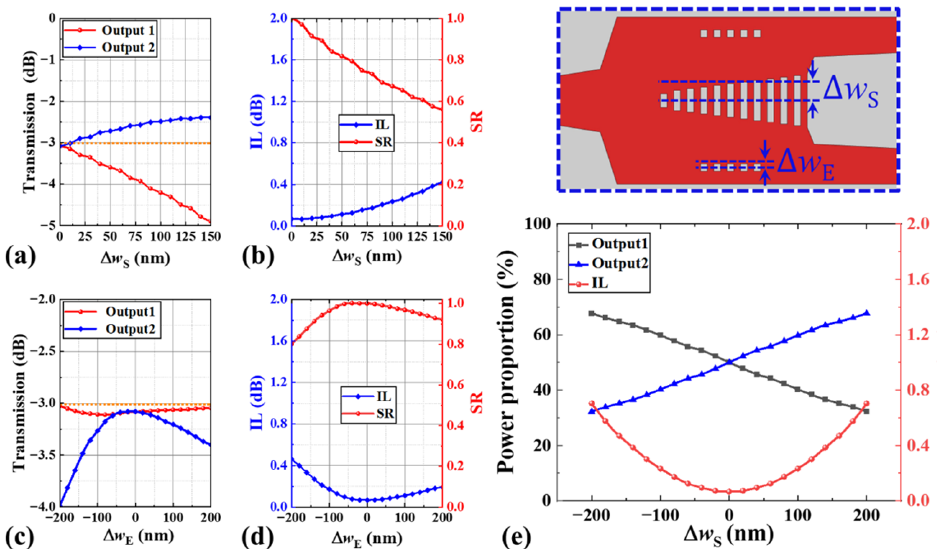
Figure 8. Fabrication tolerance analyses. Device performance (transmission, IL, and SR) variation due to ( a , b ) lateral shift (positive y ‐ direction) Δ w S of inverse ‐ tapered SWG structure, and ( c , d ) lateral shift ( y ‐ direction) Δ w E of one row of uniform SWG structures embedded in the MMI region. ( e ) Power proportion between the two output ports and the obtained device IL as a function of the lateral shift Δ w S of the inverse ‐ tapered SWG structure. The inset shows the device schematic.